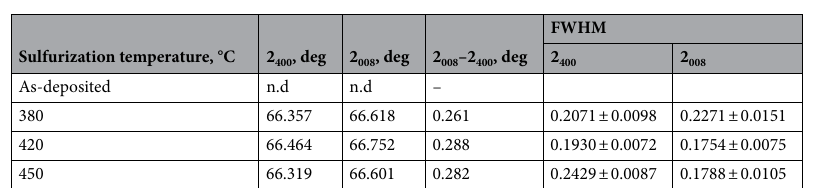
Table 4. 2 angles of CZTSSe peaks 400 and 008 and distance between those peaks, 2 008 − 2 400 for CZTSSe films sulfurized at different temperatures prior to the selenization.